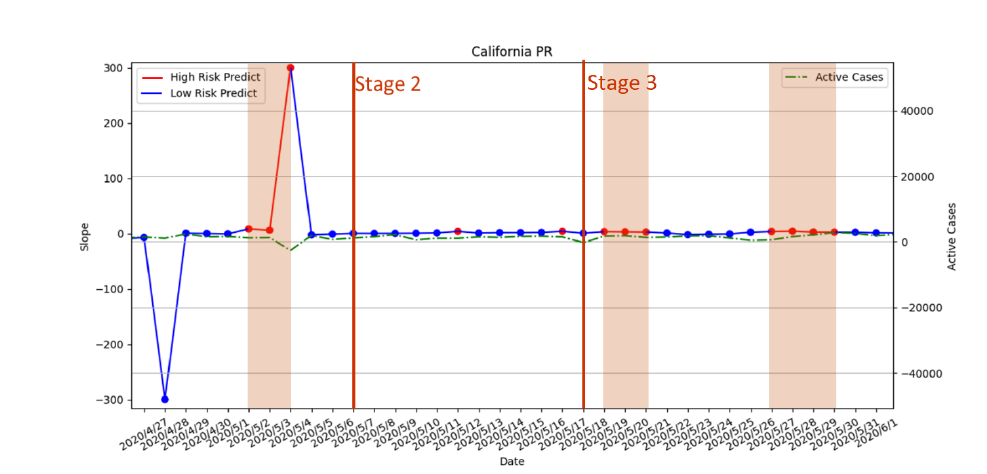
Figure 17. The result of risk analysis with PR for Stage 2 and Stage 3 policies in California.